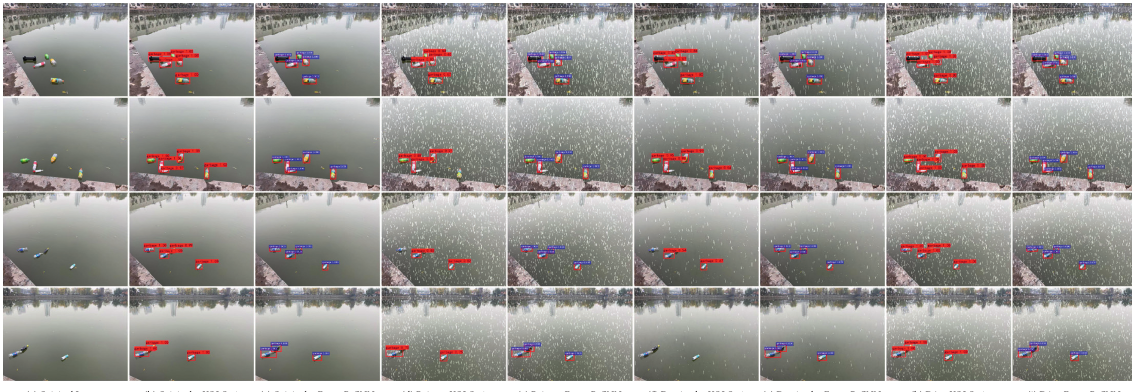
Figure 9: The water-surface garbage detection results under rainy conditions. From left to right: (a) original sharp images, original dataset- trained YOLOv4, and Faster R-CNN for detection results from (b-c) sharp images, (d-e) synthetic rainy images, (f-g) derained images, augmented dataset-trained YOLOv4, and Faster R-CNN for detection results from (h-i) synthetic rainy images, respectively. (a) Original images. (b) Original+YOLOv4. (c) Original+Faster R-CNN. (d) Rainy +YOLOv4. (e) Rainy +Faster R-CNN. (f) Derained+YOLOv4. (g)